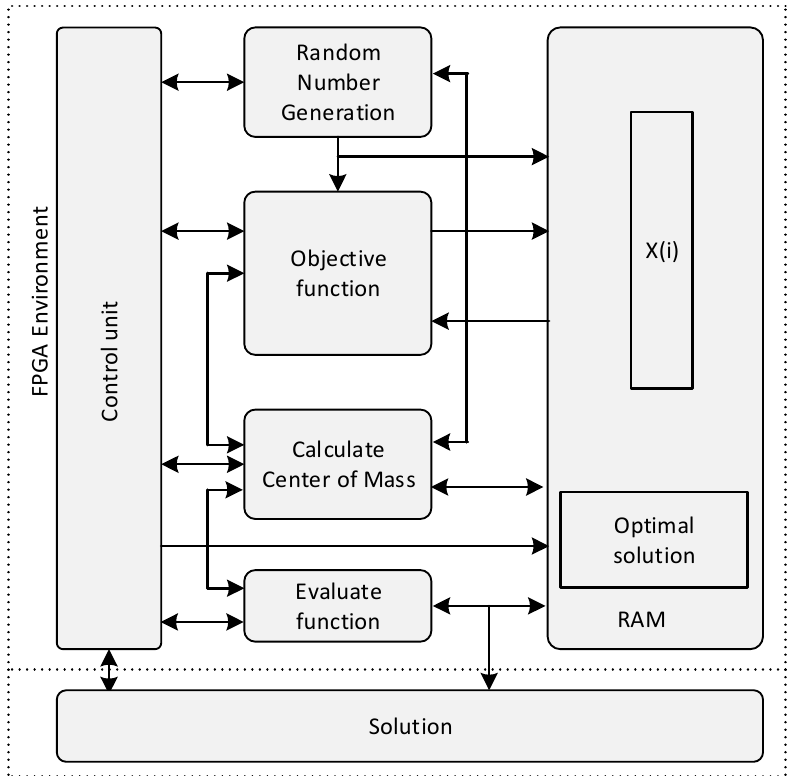
Figure 6. Top-level diagram of the BB–BC FPGA architecture.